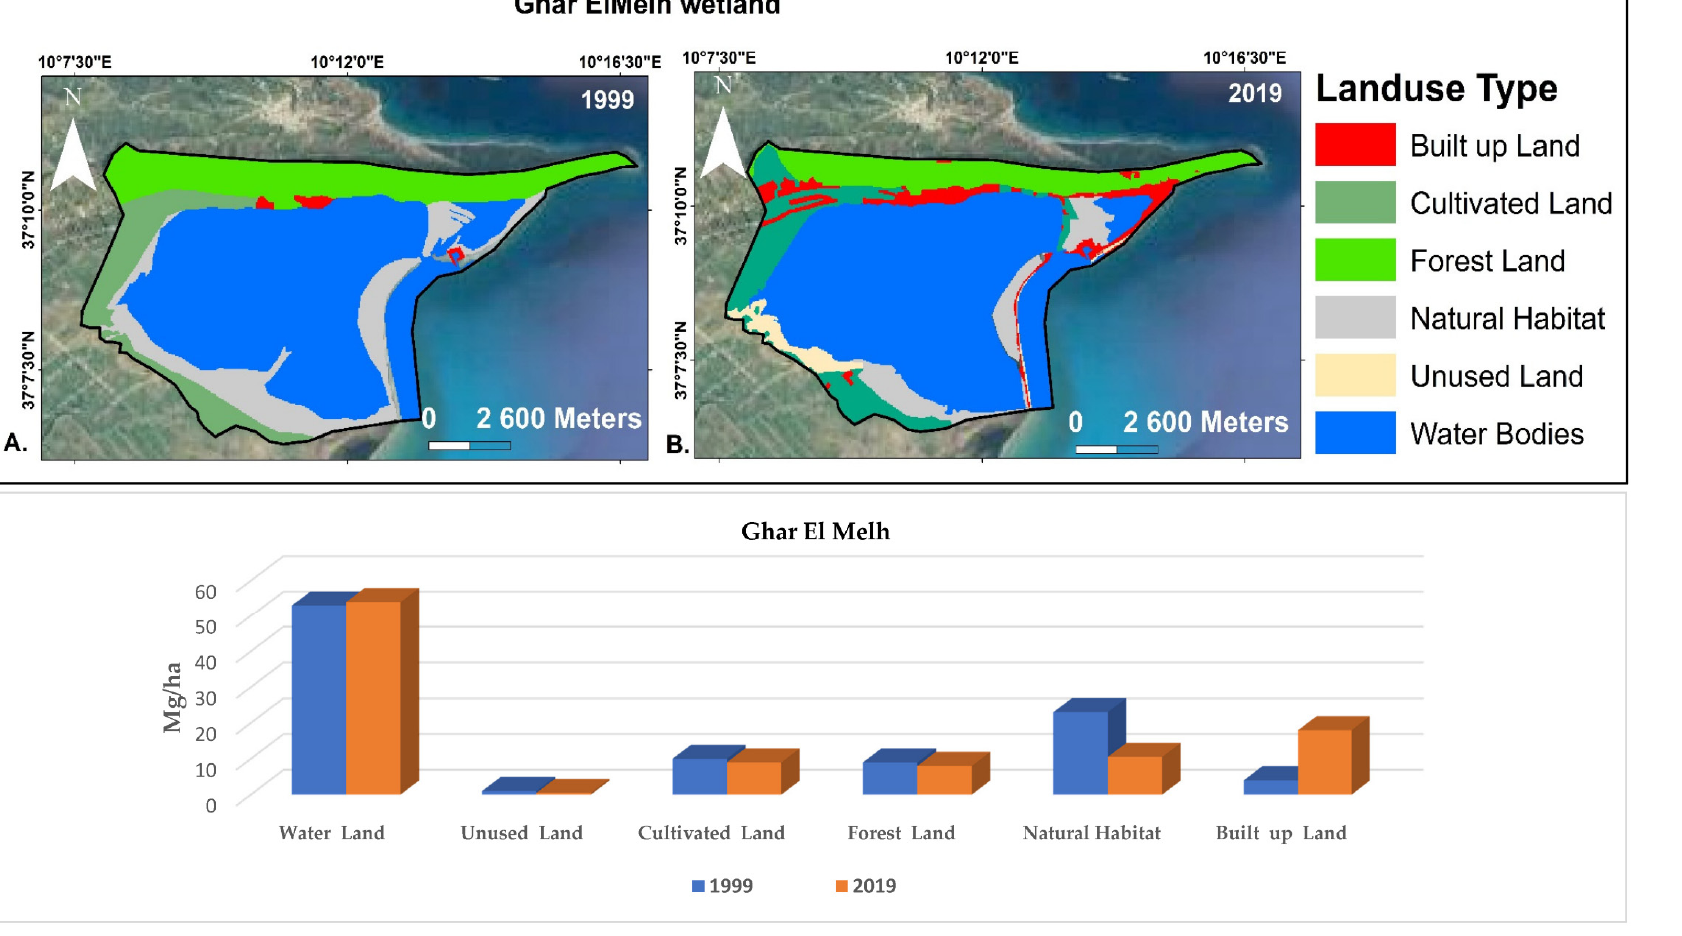
Figure 8. Maps and percentages of LULC changes in Ghar El Melh between 1999 and 2019: ( A ) LULC change of 1999; ( B ) LULC change of 2019 .